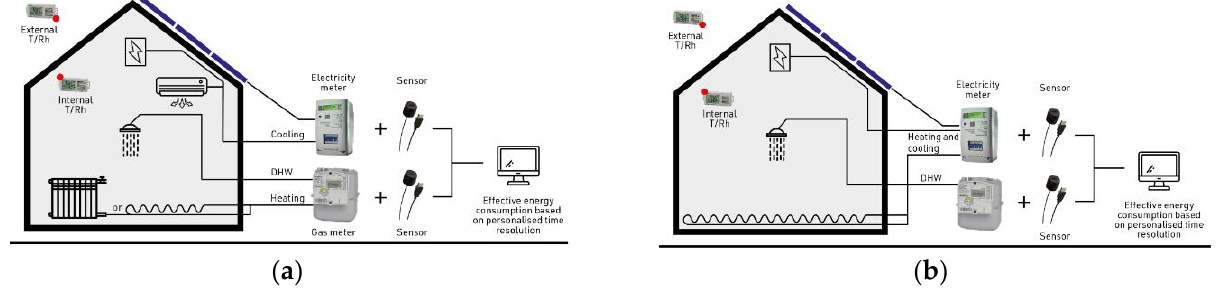
Figure 2. Medium level: ( a ) Configuration 2a: dwelling with independent systems (electrical cooling system and gas heating/DHW production); ( b ) Configuration 2b: dwelling with independent systems (electrical heating/cooling systems and gas DHW production). Source: elaborated by authors.